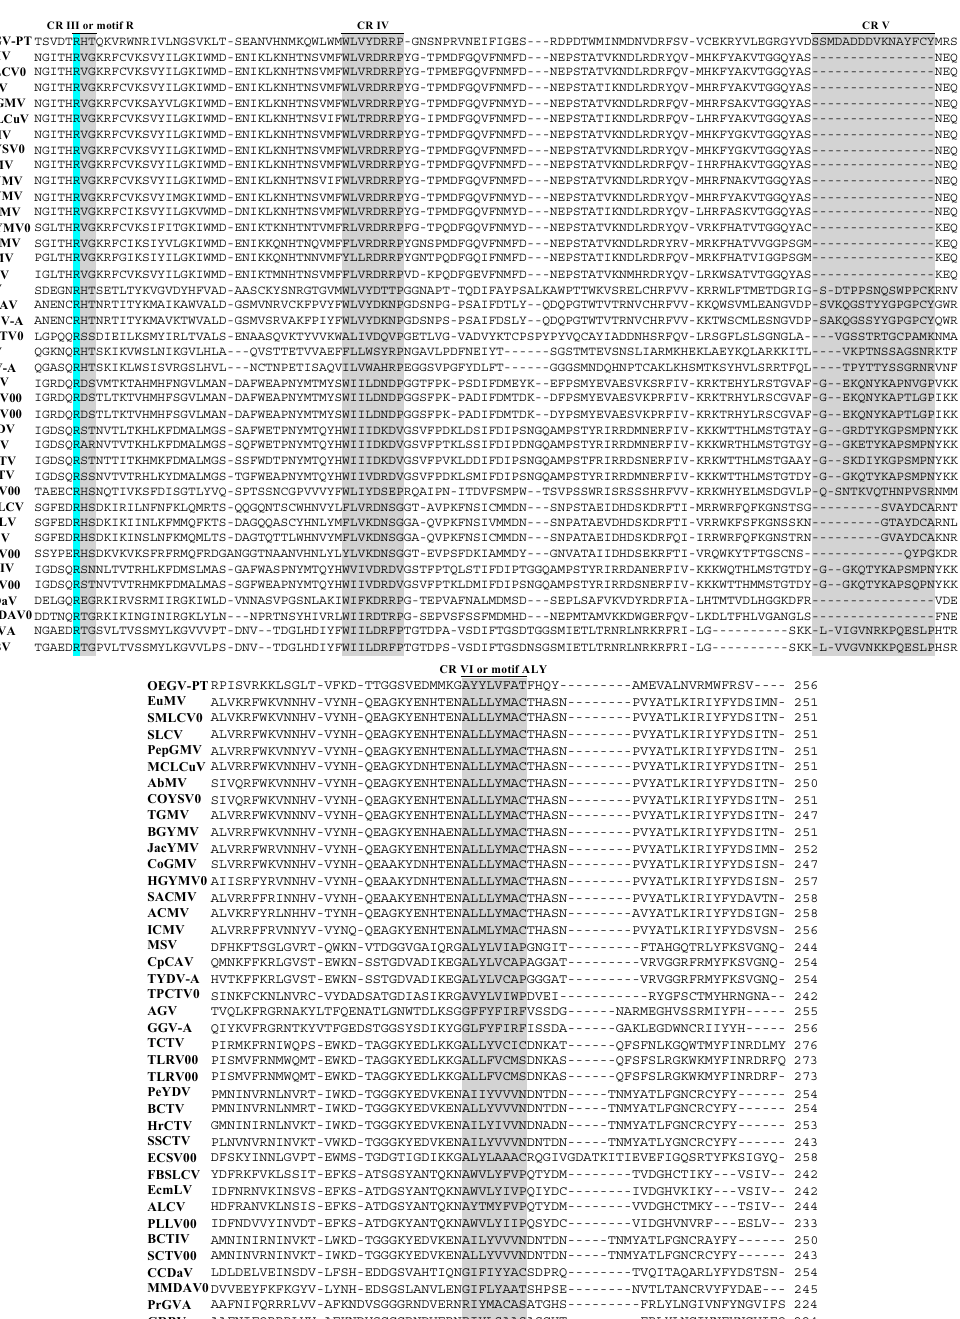
Figure 3. Multiple alignment of OEGV-PT CP protein sequences with most representative geminiviruses including some isolates that had not yet been classified into genera, retrieved from the GenBank database. Gray boxes are highlighting several conserved regions (CR) or motifs, and blue indicate 100% homology between the geminivirus. Conserved regions (CR) or motifs; CR I, motif PWRsMaGT (conserved on NW Begomovirus), CR II, CR III or putative motif candidates R, CR IV, CR V (amino acids enriched region in OEGV-PT) and CR VI or putative motif candidates ALY. Virus species and genera are NW Begomovirus (SLCV clade); EuMV, SMLCV0, SLCV, PepGMV, MCLCuV, NW Begomovirus ; AbMV, COYSV0, TGMV, BGYMV, JacYMV, OW Begomovirus ; CoGMV, HGYMV0, SACMV, ACMV, ICMV, Mastrevirus; MSV, CpCAV, TYDV-A, Topocuvirus ; TPCTV0, Turncurtovirus ; TCTV, TLRV00-1, TLRV00-2, Curtovirus ; PeYDV, BCTV, HrCTV, SSCTV, Eragrovirus ; ECSV00, Capulavirus ; FBSLCV, EcmLV, ALCV, PLLV00, Becurtovirus ; BCTIV, SCTV00, Grablovirus ; PrGV-A, GRBV, Citlodavirus ; CCDaV, Maldovirus ; AGV, GGV-A, and unassigned genera; MMDaV. The BV1/MP of OEGV-PT DNA-B, showed the absence of the putative tyrosine phos- phorylation site [RK]-x(2,3)-[DE]-x(2,3)-Y, a site typically present in the NW Begomovirus and absent in OW Begomovirus . However, the comparison of the putative tyrosine phos-